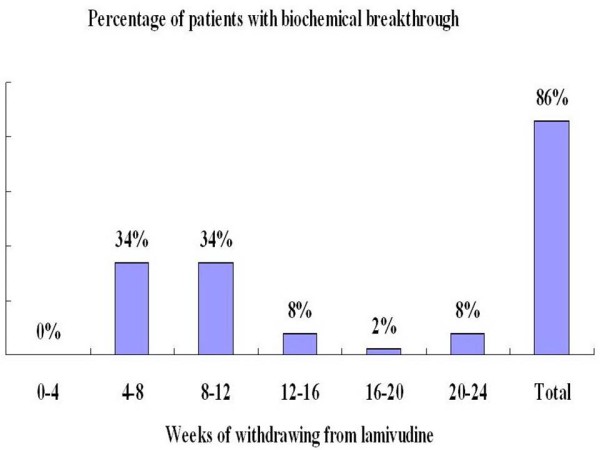
Percentage of patients with biochemical breakthrough occurred at the different time after lamivudine withdrawal.